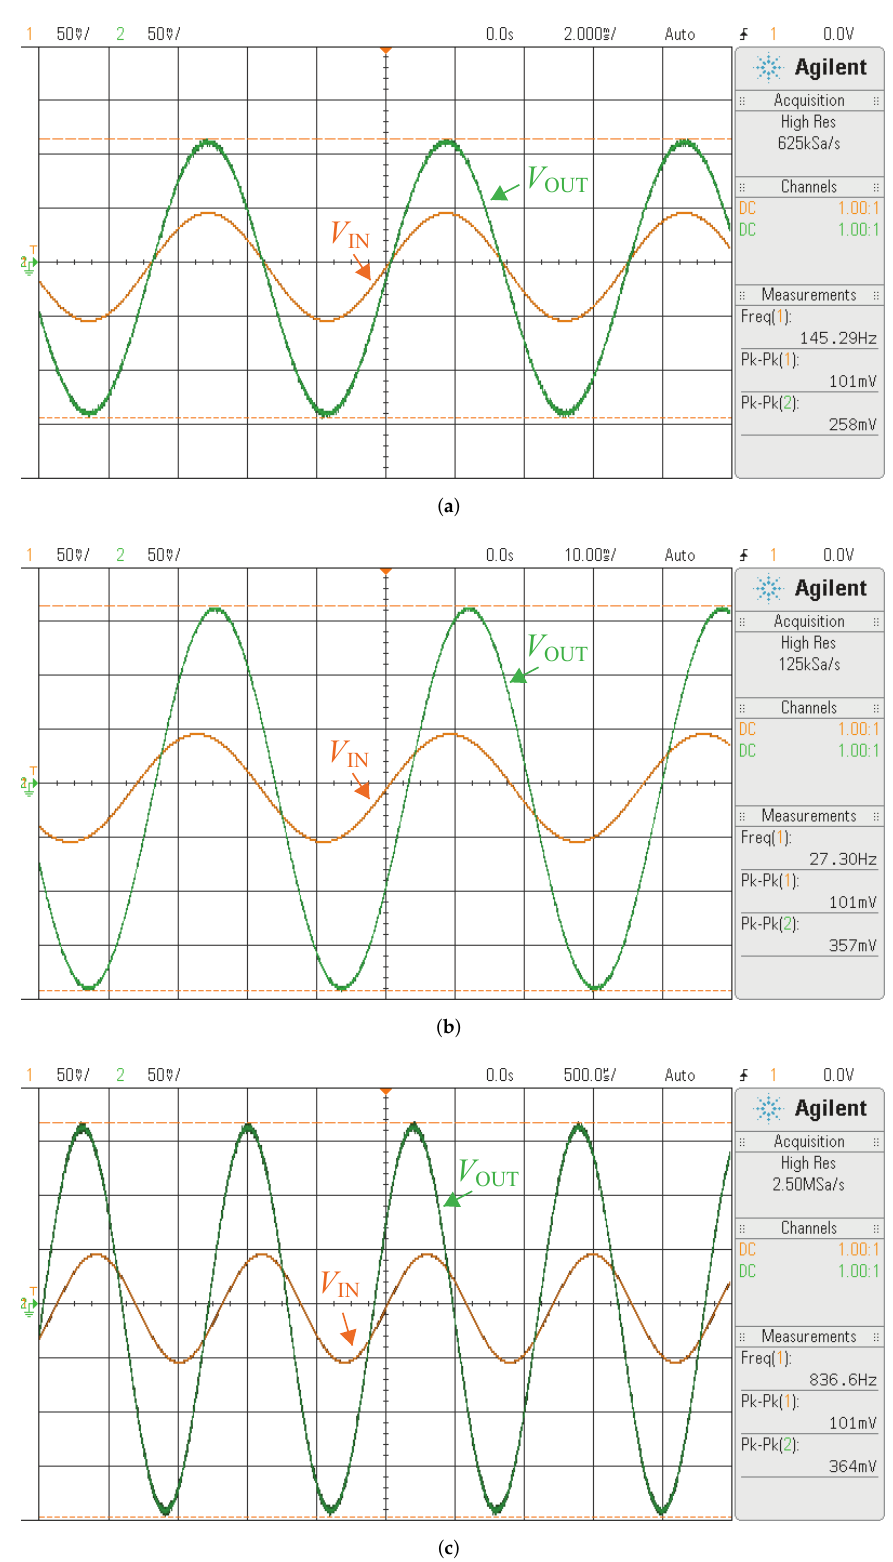
Figure 16. Time-domain input-output waveforms observed in oscilloscope for the proposed FIBPF with an input frequency of ( a ) ω 0 = 912.44 rad/s, ( b ) ω H,low = 171.53 rad/s, and ( c ) ω H,high = 5.26